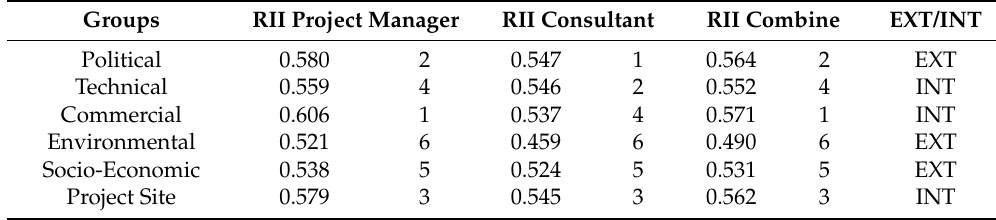
Table 4. Relative importance index (RII) and Ranking of Uncertainty in